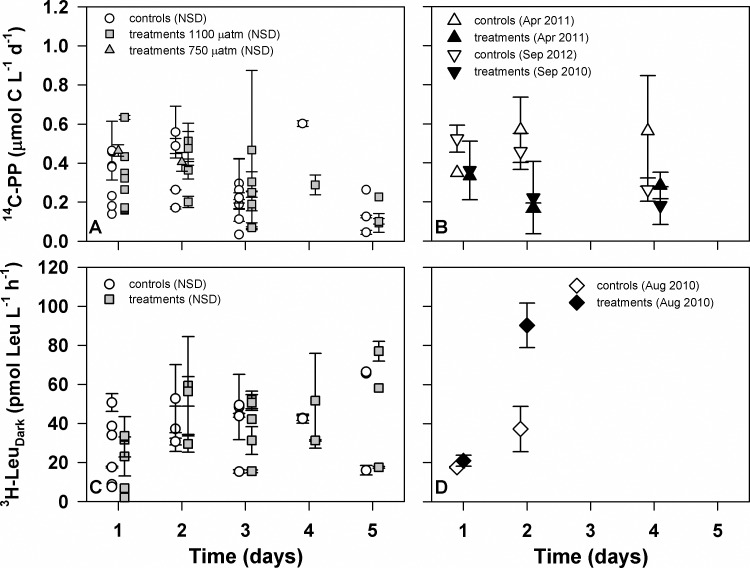
Results of pCO2 bubbling experiments.Measured rates of 14C-PP (panel A) and 3H-LeuDark incorporation (panel C) from all experiments (n = 8 and n = 7, respectively) where no significant differences (NSD) were observed between controls (white circles) and elevated pCO2 treatments at 1100 μatm (grey squares) and 750 μatm (grey triangles) are depicted. Also shown are rates of 14C-PP (panel B) and 3H-LeuDark incorporation (panel D) from experiments where significant differences (two-way ANOVA; p<0.05) were observed between controls (open symbols) and elevated pCO2 (black symbols) treatments. Dates of experiments showing significant differences are given in the legend.